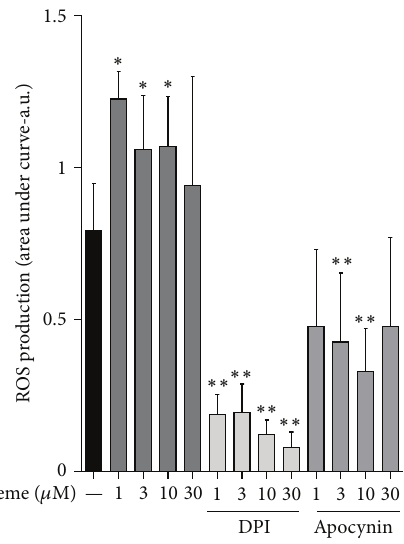
Figure 1: Heme induces ROS production by AM. Rat AMs (2 × 10 5 /mL) were placed in a white flat-bottom 96-well plate. Cells were pretreated with DPI (10 𝜇 M) and apocynin (10 𝜇 M) and then stimulated or not with heme (1–30 𝜇 M) for 1 hour in the presence of luminol as a chemiluminogenic probe (500mM). Absorbance intensity at 595 nm was directly proportional to ROS production by AM. DPI and apocynin alone had no effect. The data shown are representative of three independent experiments. The mean ± S.D. is presented. ∗ 𝑃 < 0.05 when compared with controls. ∗∗ 𝑃 < 0.05 when compared to cells treated with heme.